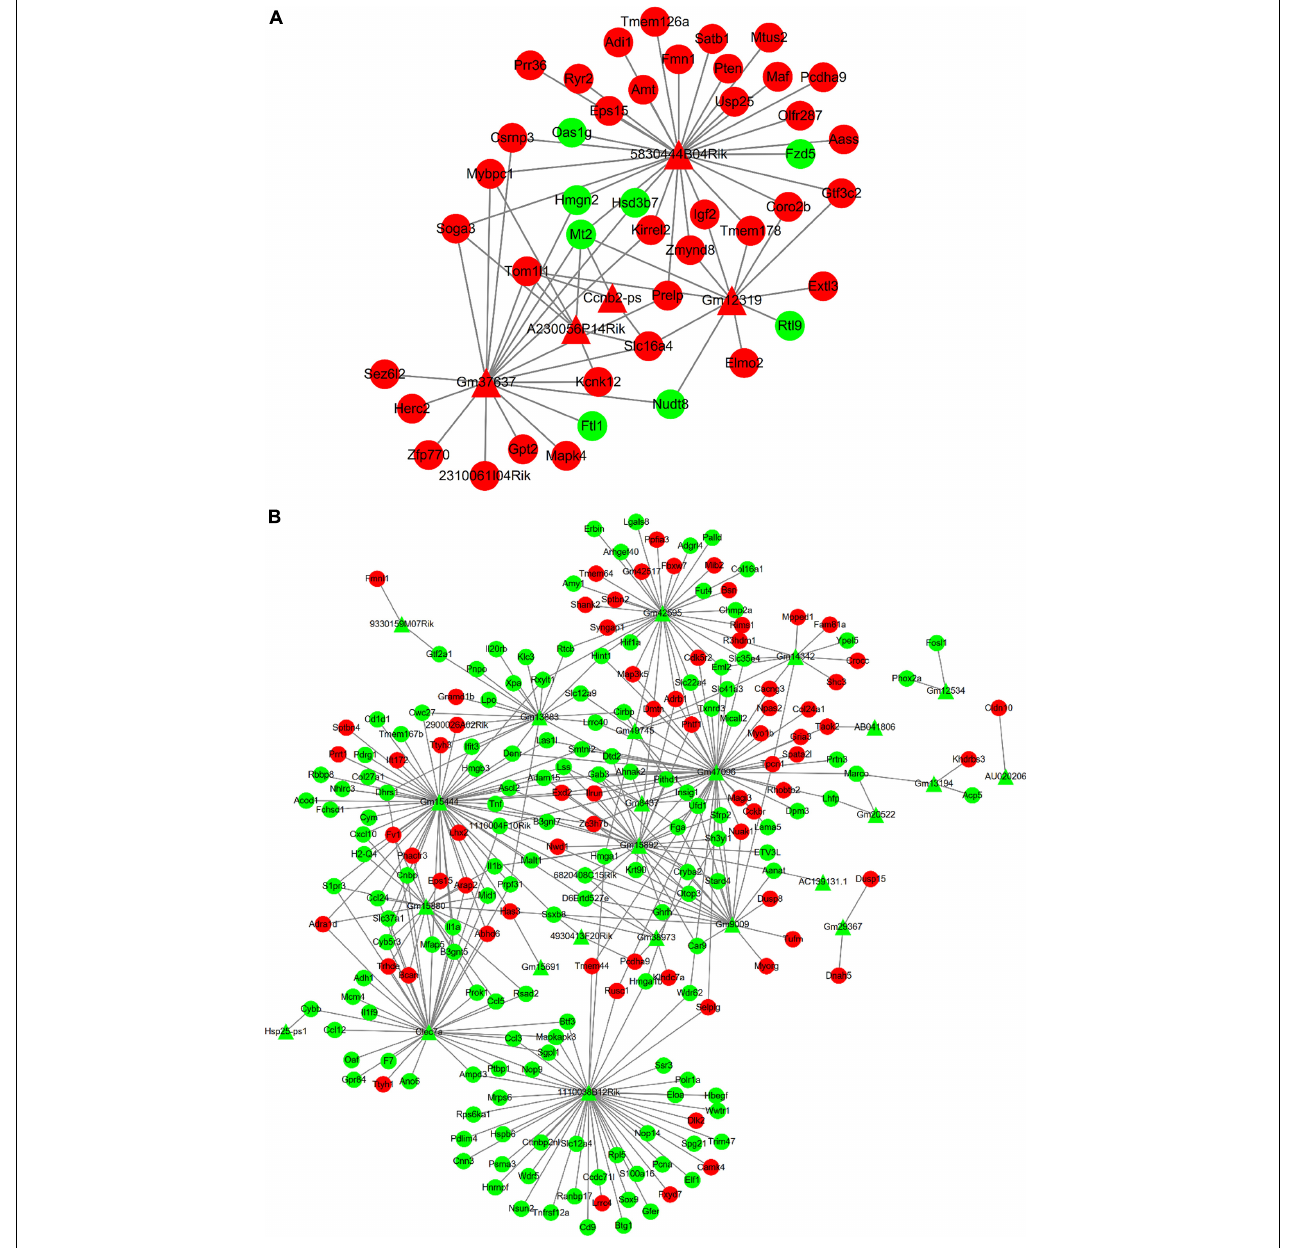
FIGURE 6 | In the interaction network, triangles represent lncRNAs and circles represent mRNAs. And red represents up-regulated genes and green represents down-regulated genes. (A) The interaction network between up-regulated DE lncRNAs and DE mRNAs. (B) The interaction network between down-regulated DE lncRNAs and DE